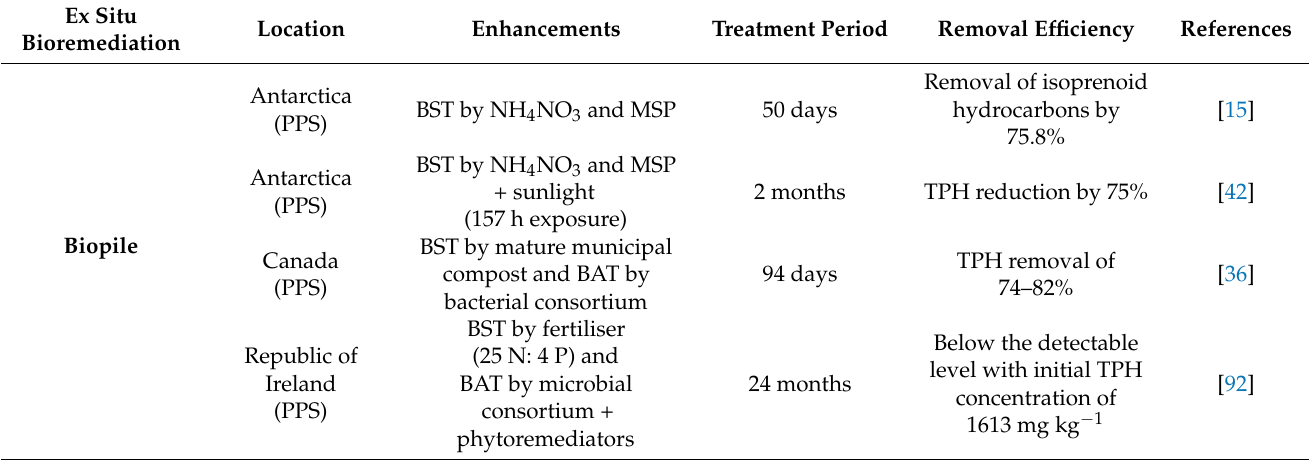
Table 5. Enhanced ex situ bioremediation studies by biostimulation and/or bioaugmentation in cold regions. Ex Situ Bioremediation